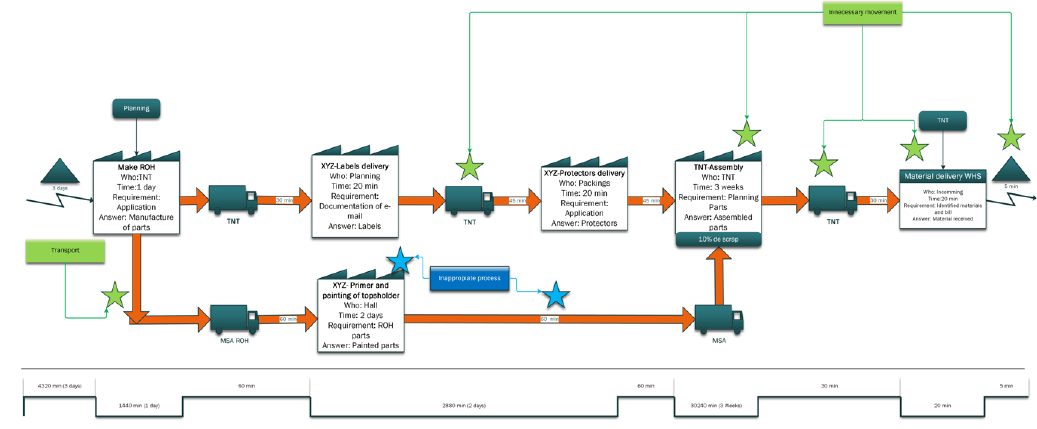
Figure 11. The second part of seven of the Current State Value Stream Map with wastes. Appl. Sci. 2019 , 9 , x FOR PEER REVIEW